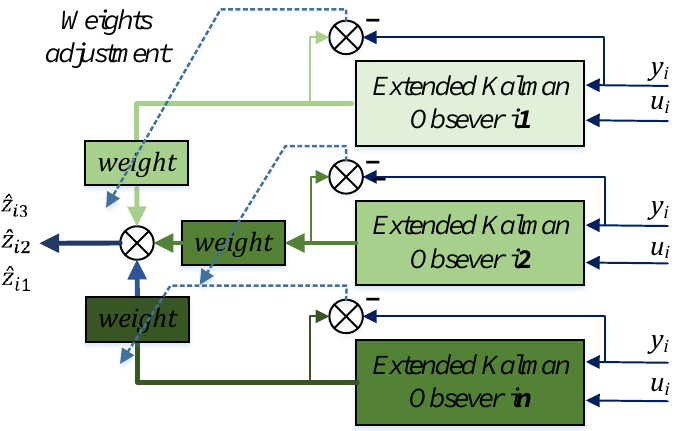
Figure 3. Block diagram of the Multiple-model augmented-state Extended Kalman Observer.